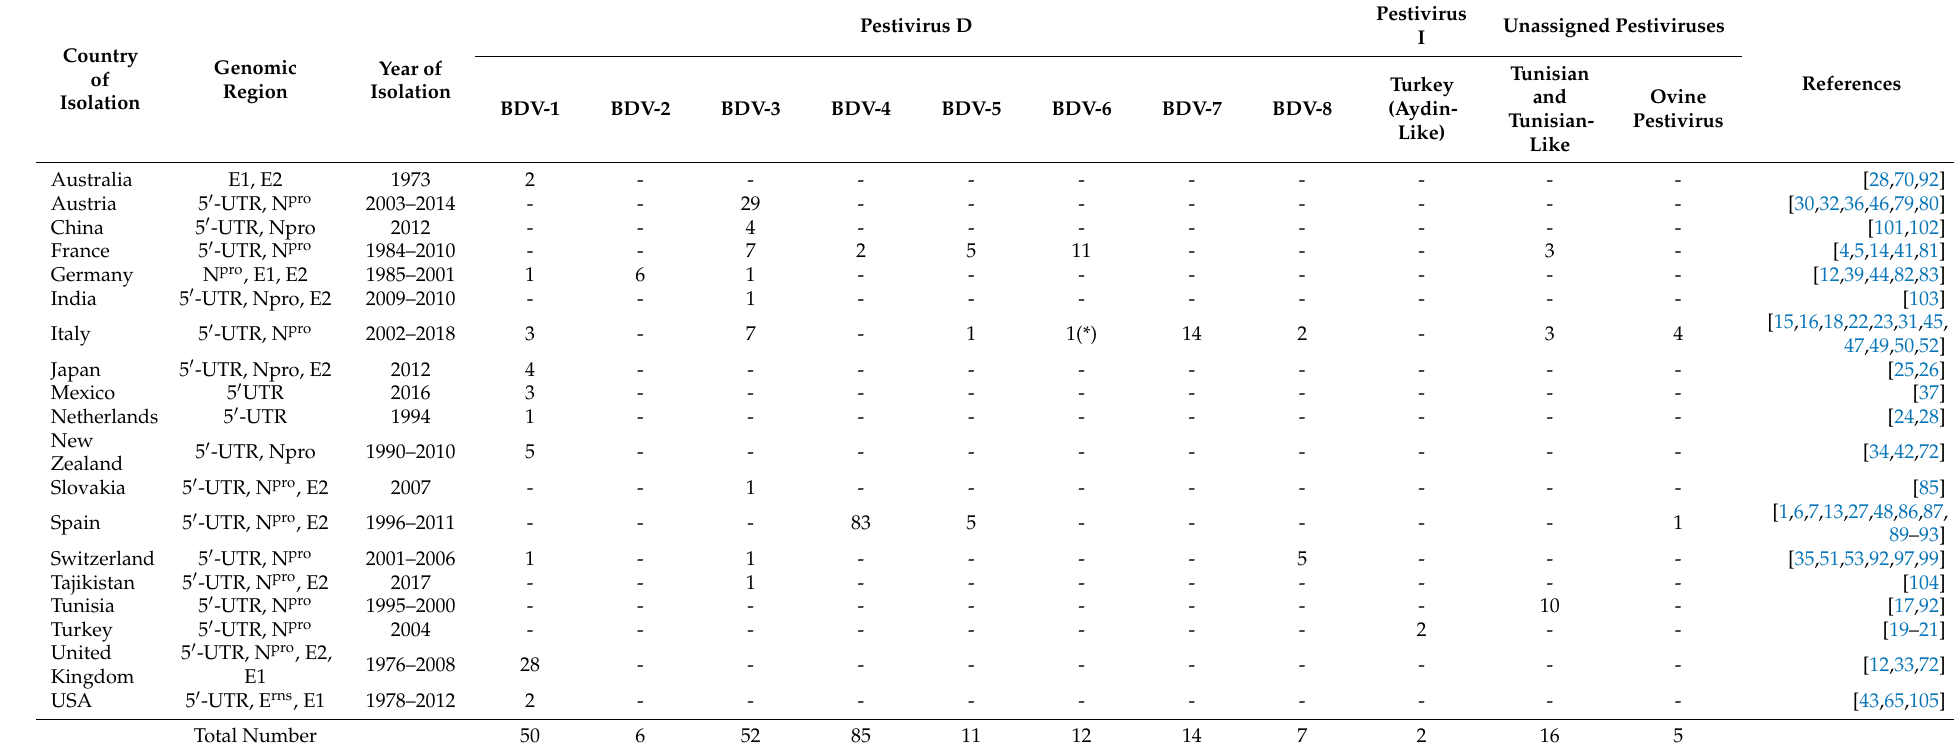
Table 2. Global distribution of BDV genotypes and other small ruminant